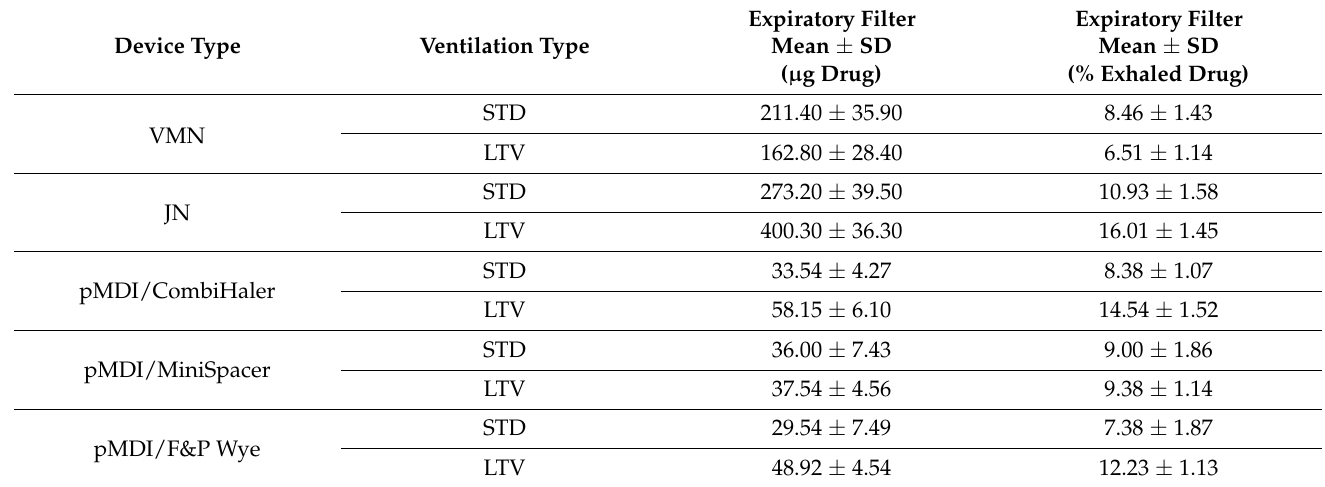
Table 4. Mean ± standard deviation of drug ( µ g) captured on expiratory filter across three devices with differing ventila- tion